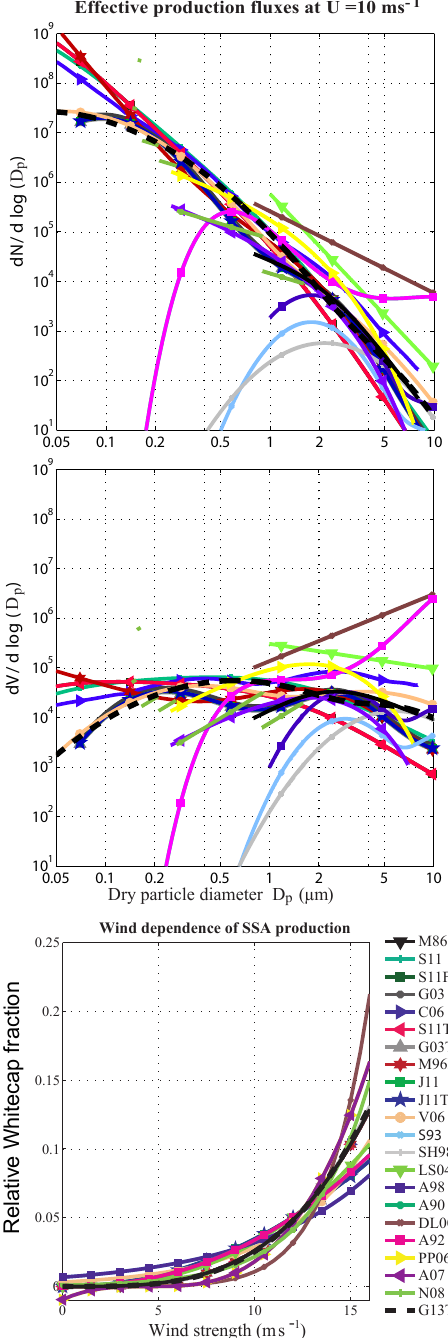
Fig. 2. Top: number density fluxes of several SSA-generating func- tions from the literature, for a wind speed of 15ms − 1 . A total of 22 different functions are shown in this plot and they span several orders of magnitude for any given aerosol size; for details see Ap- pendix. Middle: same as top, but for volume. Bottom: the wind- speed dependence of SSA production for investigated source func- tions. For the source functions that have wind dependency varying with size, wind dependency is taken at D p = 1µm. The graphs have been normalized to have the same area. For acronyms in the legend, see Table 1. Atmos. Chem. Phys., 14, 1277–1297,